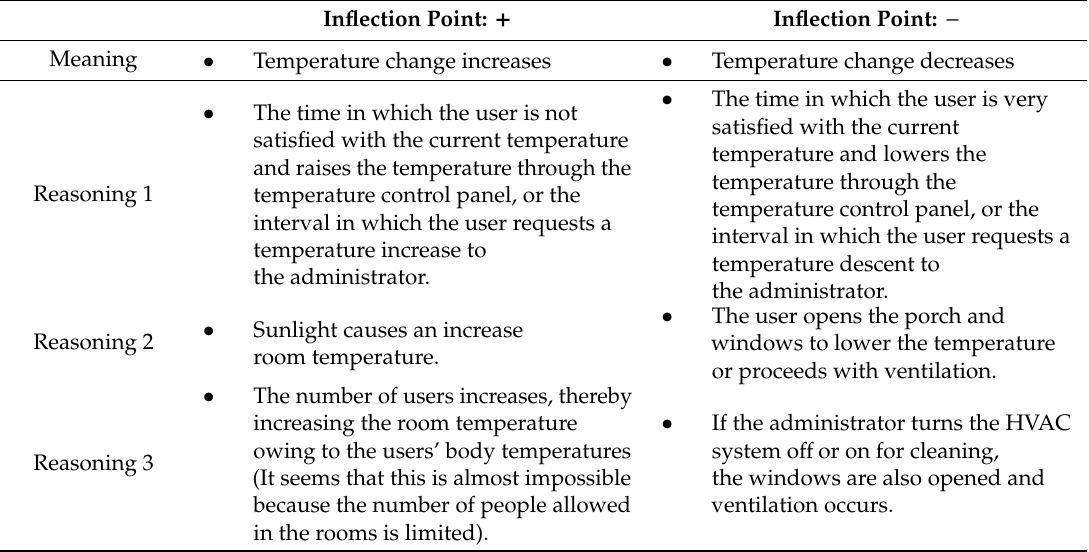
Table 6. Interpretations and Reasonings of Inflection Points.